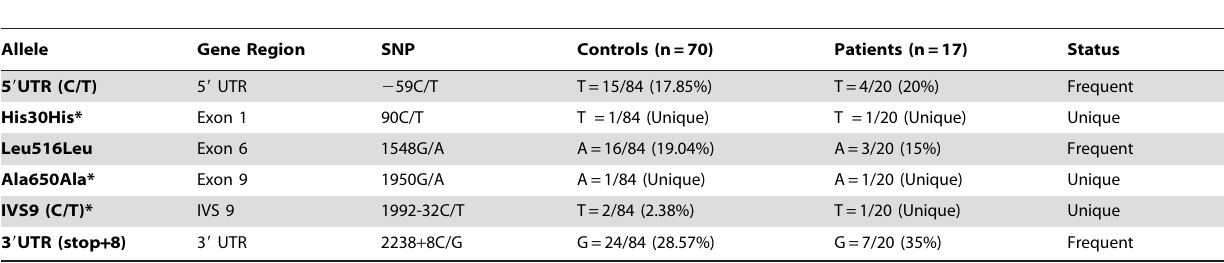
Table 4. SNP analysis in ABCD1 gene in X-linked adrenoleukodystrophy cases and healthy controls.